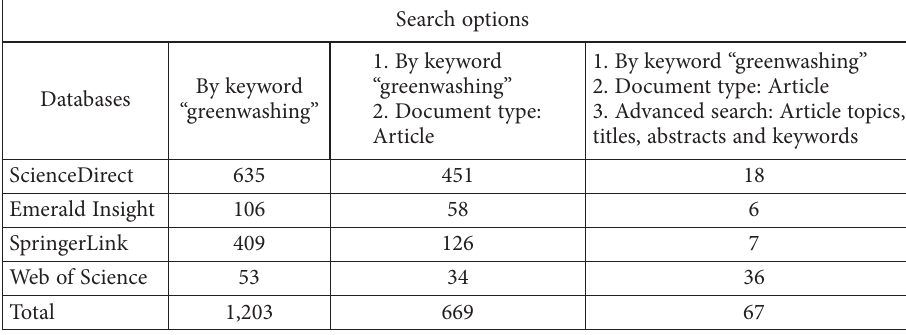
Table 1. Search options and returned results for each database